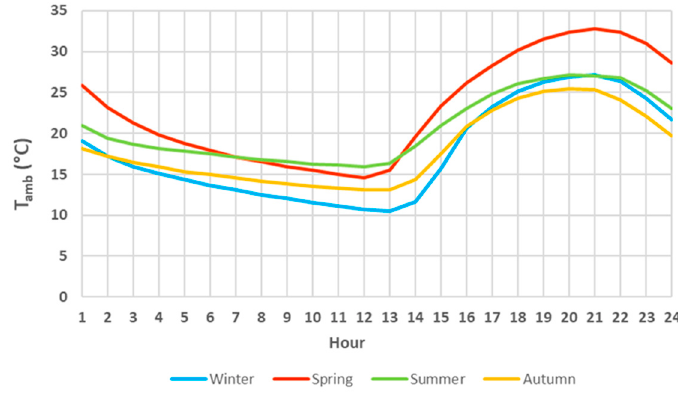
Figure 8. Average temperature per hour for each